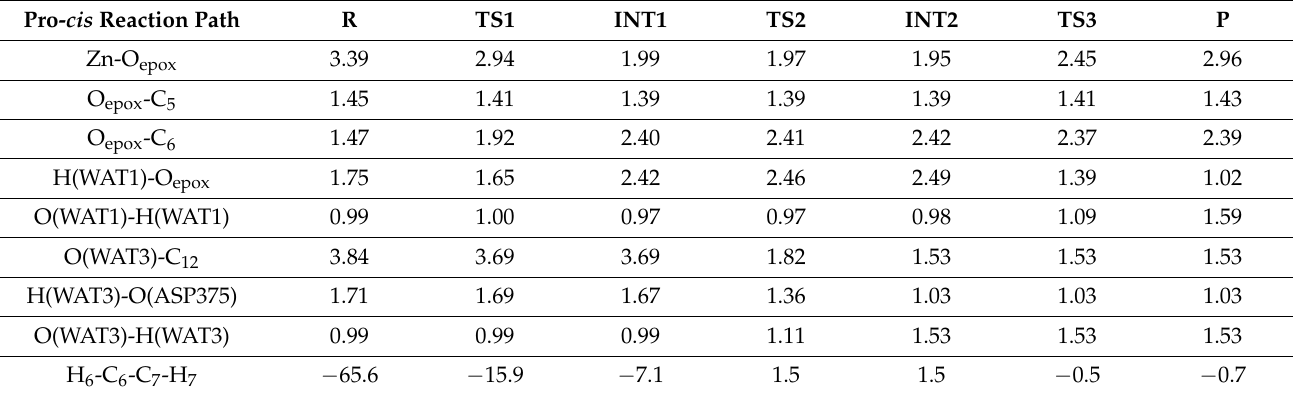
Table 1. Most relevant distances (in Å) and dihedral angle (in degrees) defining the E / Z character of the C 6 -C 7 bond for the stationary structures of the complete mechanism of conversion of LTA 4 to LTB 4 (pro- cis reaction path) catalysed by LTA 4